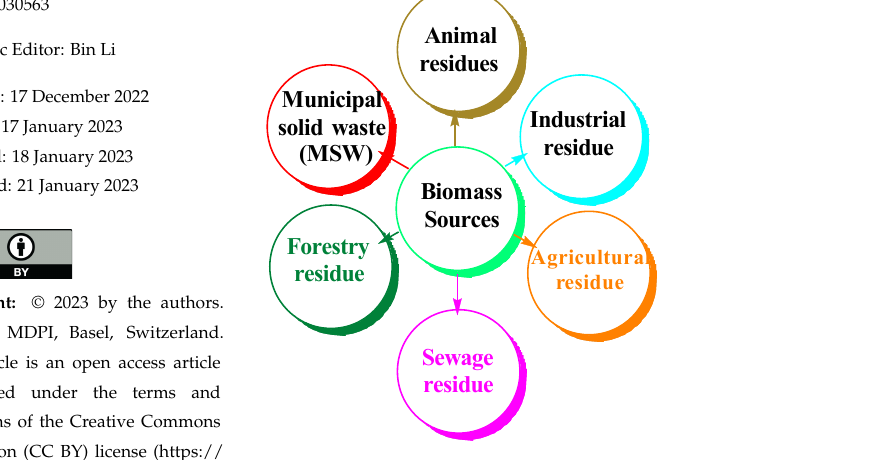
Figure 1. The most important biomass sources (adapted from